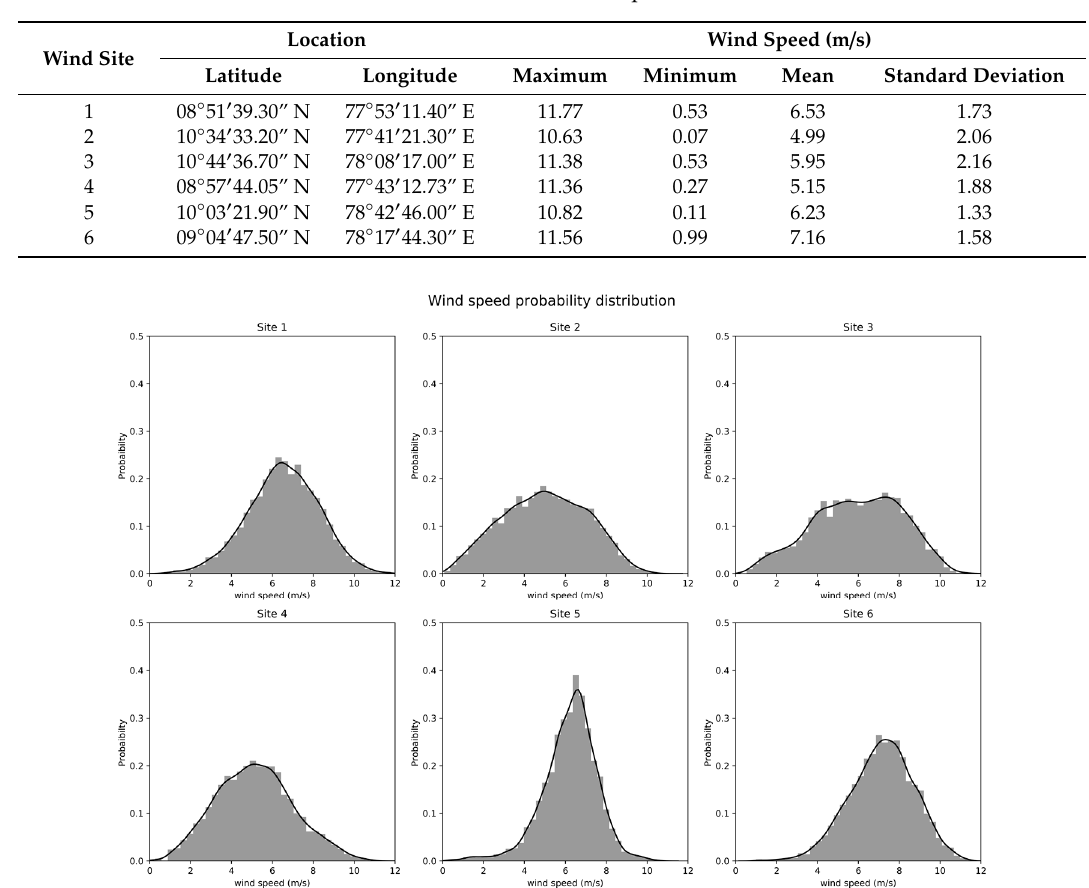
Figure 10. Probability distribution of wind speed at different data collection sites .